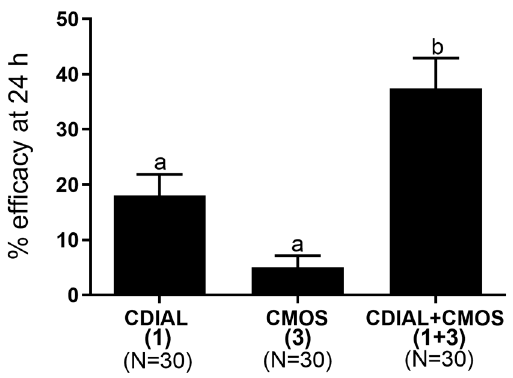
Figure 4. Synergism between CDIAL ( 1 ) and CMOS ( 3 ) against 1st instar larvae of Aedes aegypti . Larvicidal e ffi cacy in 1st instar larvae was defined as the percentage (after Abbott’s correction) that died within 24 h after adding CDIAL (50 µ M), CMOS (75 µ M), or the combination of CDIAL (50 µ M) and CMOS (75 µ M) to the rearing water. Values are means ± SEM; N = number of independent replicates of 5 larvae